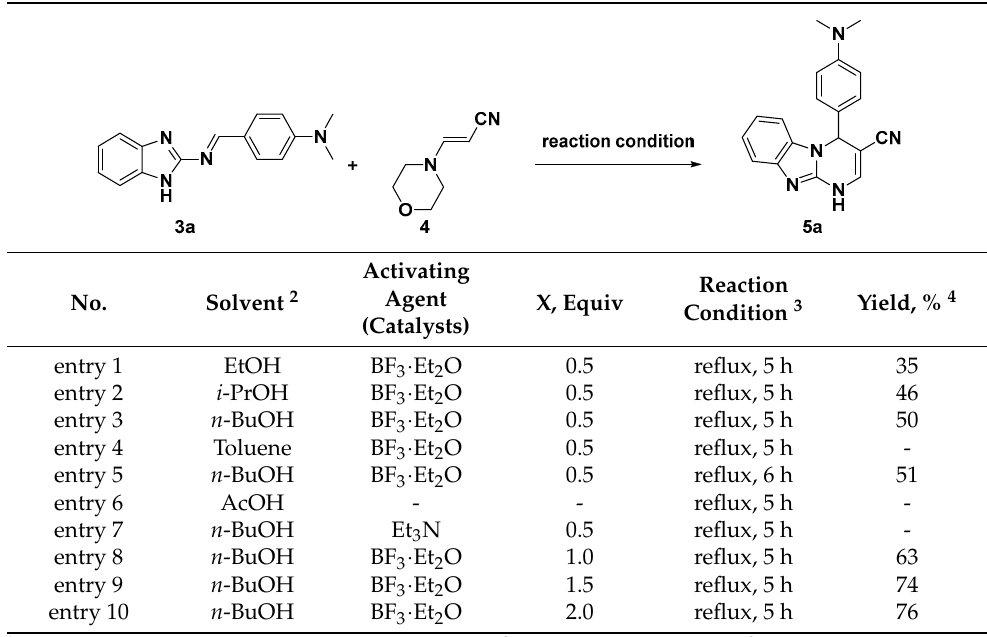
Table 1. Optimization of the reaction conditions for dihydropyrimidin 5a 1 .